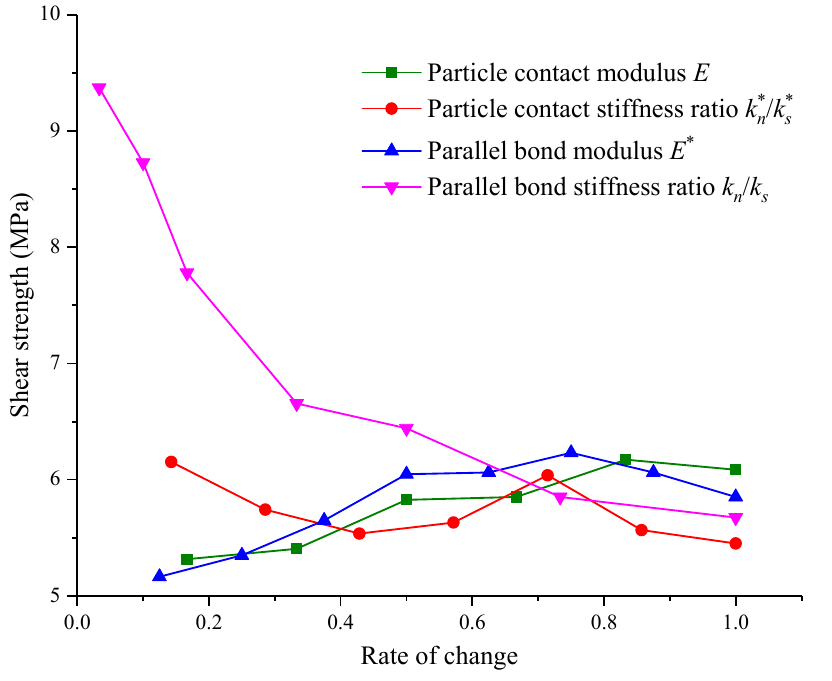
Figure 11. Effects of micro-parameters on shear strength.